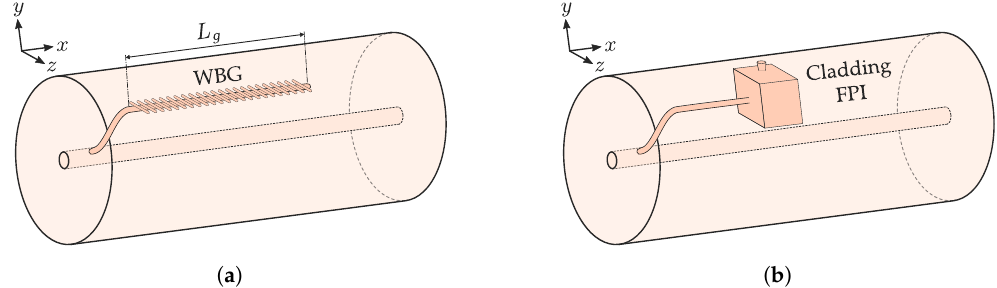
Figure 10. ( a ) Schematic of a BWG. ( b ) Schematic of a Cladding Fabry–Perot Cavity connected through a